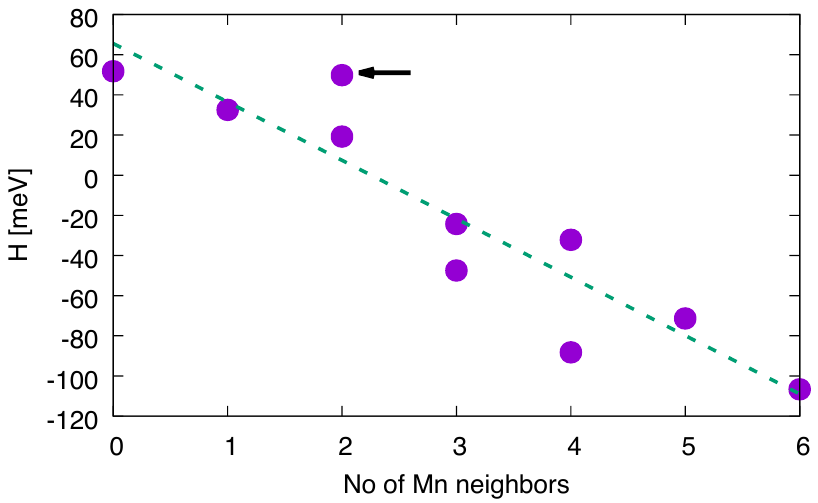
Figure 2. Hydrogen solution enthalpy as function of the number of Mn neighbors. For some cases, there are different energy values, which are due to different atomic arrangements, e.g., trans or cis configurations (see [6] for a detailed discussion). The dashed curve is a linear fit. The black arrow points to the trans configuration with two neighboring Mn atoms at opposite ends of the octahedron surrounding the H atom. This configuration is the reference for the Fe-Mn-Al-H